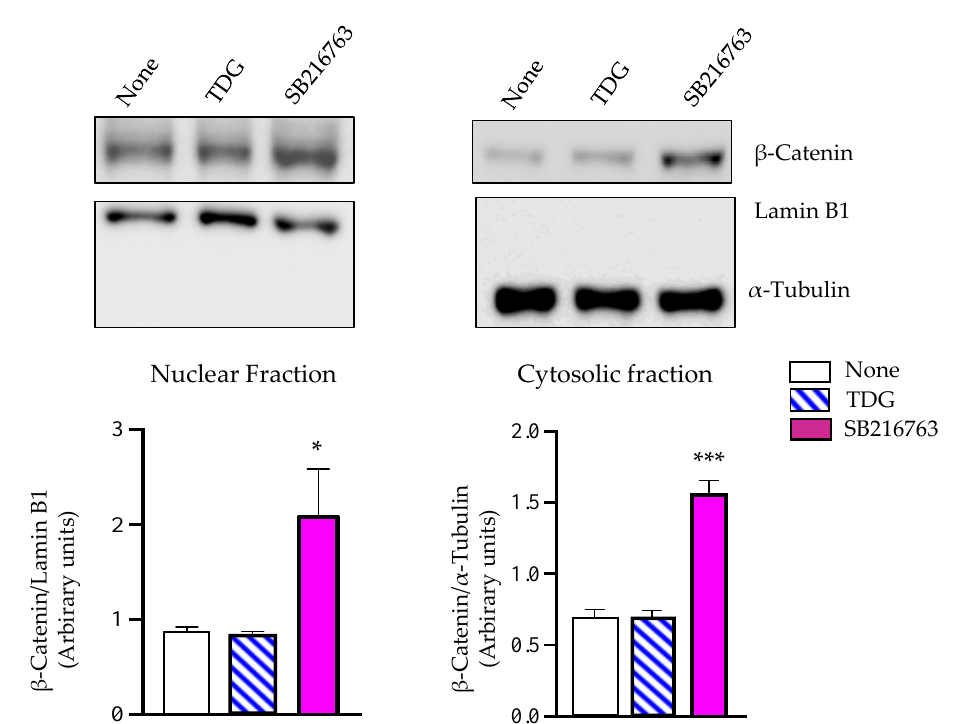
Figure 5. Effects of GSK-3 β inhibitors on subcellular localization of β -catenin in human neuroblastoma SH-S5Y5 cells. Cells were incubated for 24 h in the presence or in the absence of 10 µ M of Tideglusib (TDG) or SB 216763. After treatment, cells were collected and lysed to obtain the nuclear and cytosolic fractions that were analyzed by Western blotting. Lamin B1 and α -Tubulin antibodies were used as loading and purity control of the nuclear and cytosolic fractions, respectively. A representative experiment is shown. Densitometric analyses represent mean ± SEM of six different experiments (* p < 0.05 and *** p < 0.001 significantly different from untreated cells).